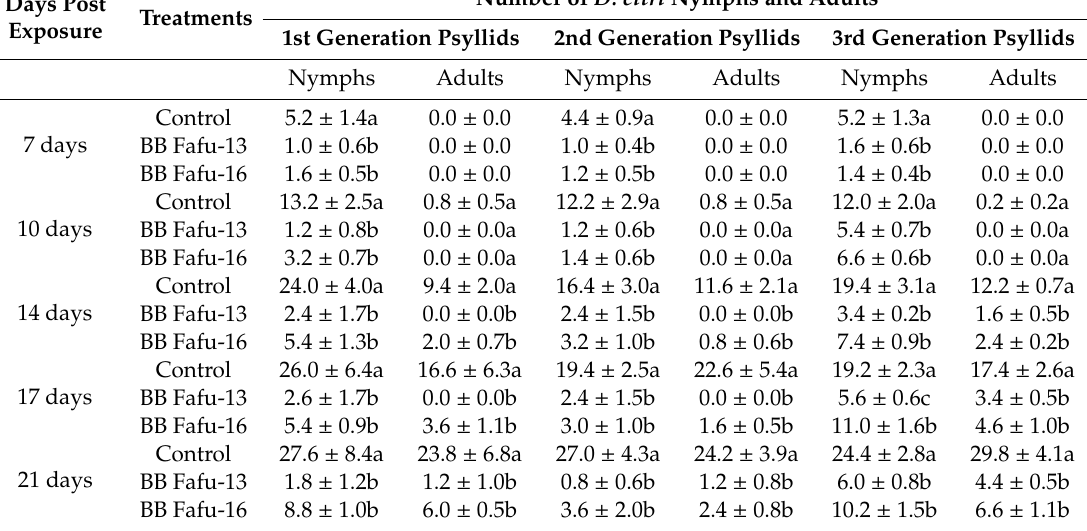
Table 3. The e ff ects of endophytic Beauveria bassiana isolates (BB Fafu-13 and BB Fafu-16) on the development of three successive generations of Asian citrus psyllid ( Diaphorina citri ) assessed at di ff erent days (7, 10, 14, 17, and 21 days) post exposure to endophyte-challenged Citrus limon